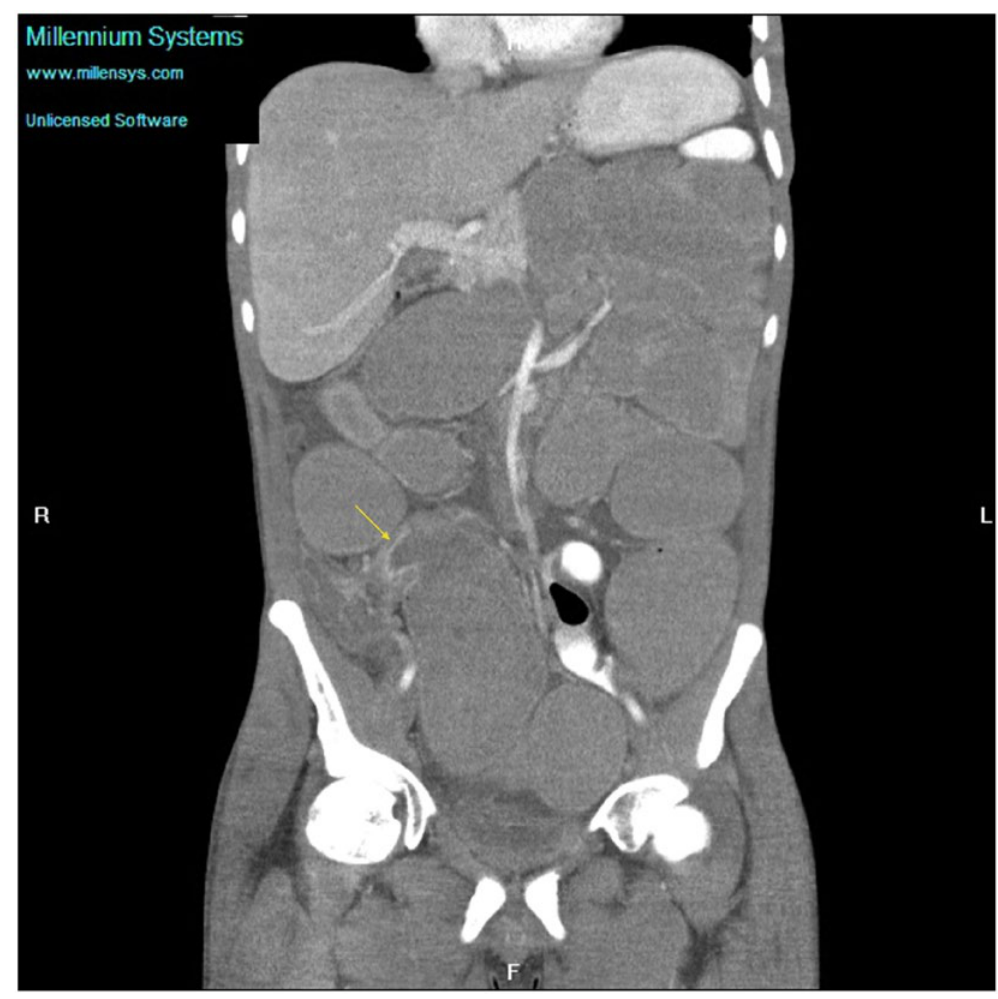
Figure 5: Coronal CT abdomen showing an abrupt beak-like transition point in the right iliac fossa with mural hyperenhancement (arrow) secondary to Crohn’s